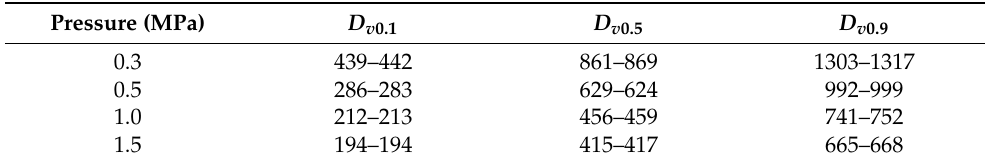
Table 3. Variations in volumetric diameters (range, μm) as predicted by regression lines reported in Table 2.